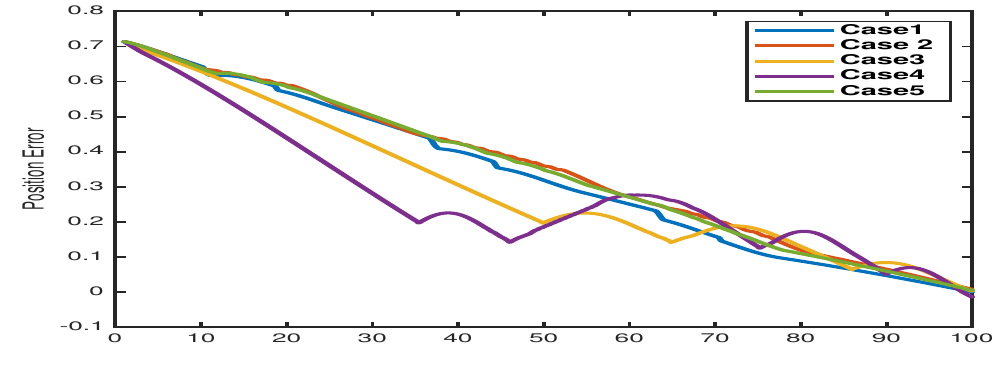
Figure 18. Position error for the five simulation